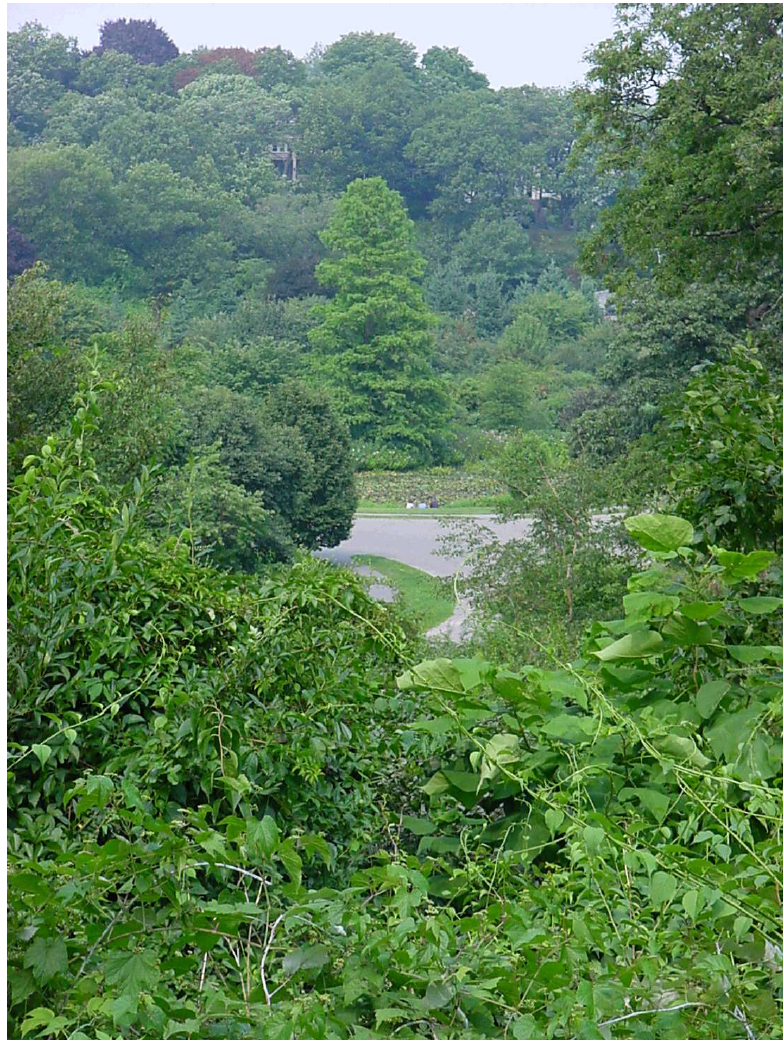
Figure 2. The Emerald Necklace looking toward Brookline, Massachusetts, an example of a greenway, green infrastructure, and the practice of sustainability (copyright © 2004 Jon Bryan Burley, all rights reserved and used with permission).